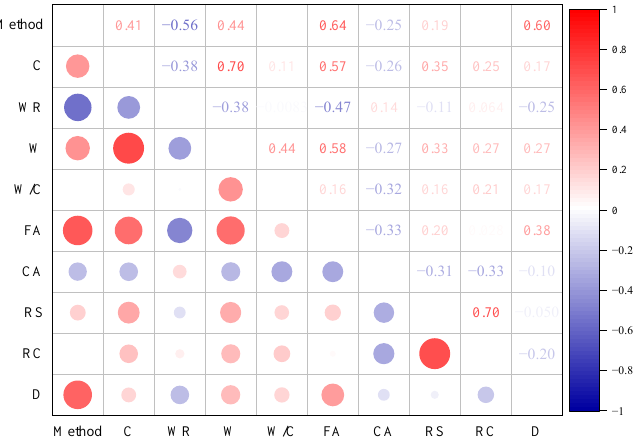
Method C Figure 1. Heat map of correlation coefficients for input and output Figure 1. Heat map of correlation coefficients for input and output variables.